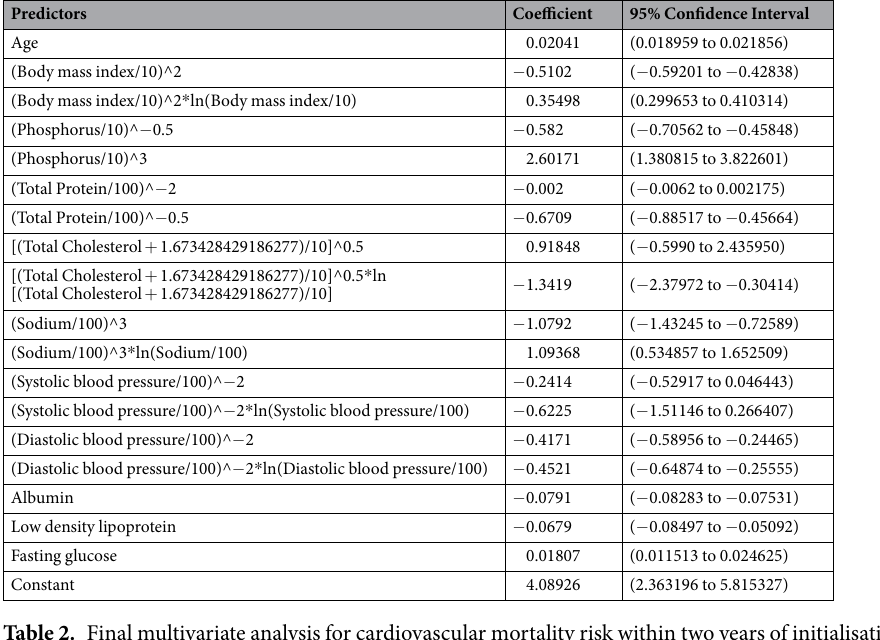
Table 2. Final multivariate analysis for cardiovascular mortality risk within two years of initialisation of peritoneal dialysis in derivation cohort.